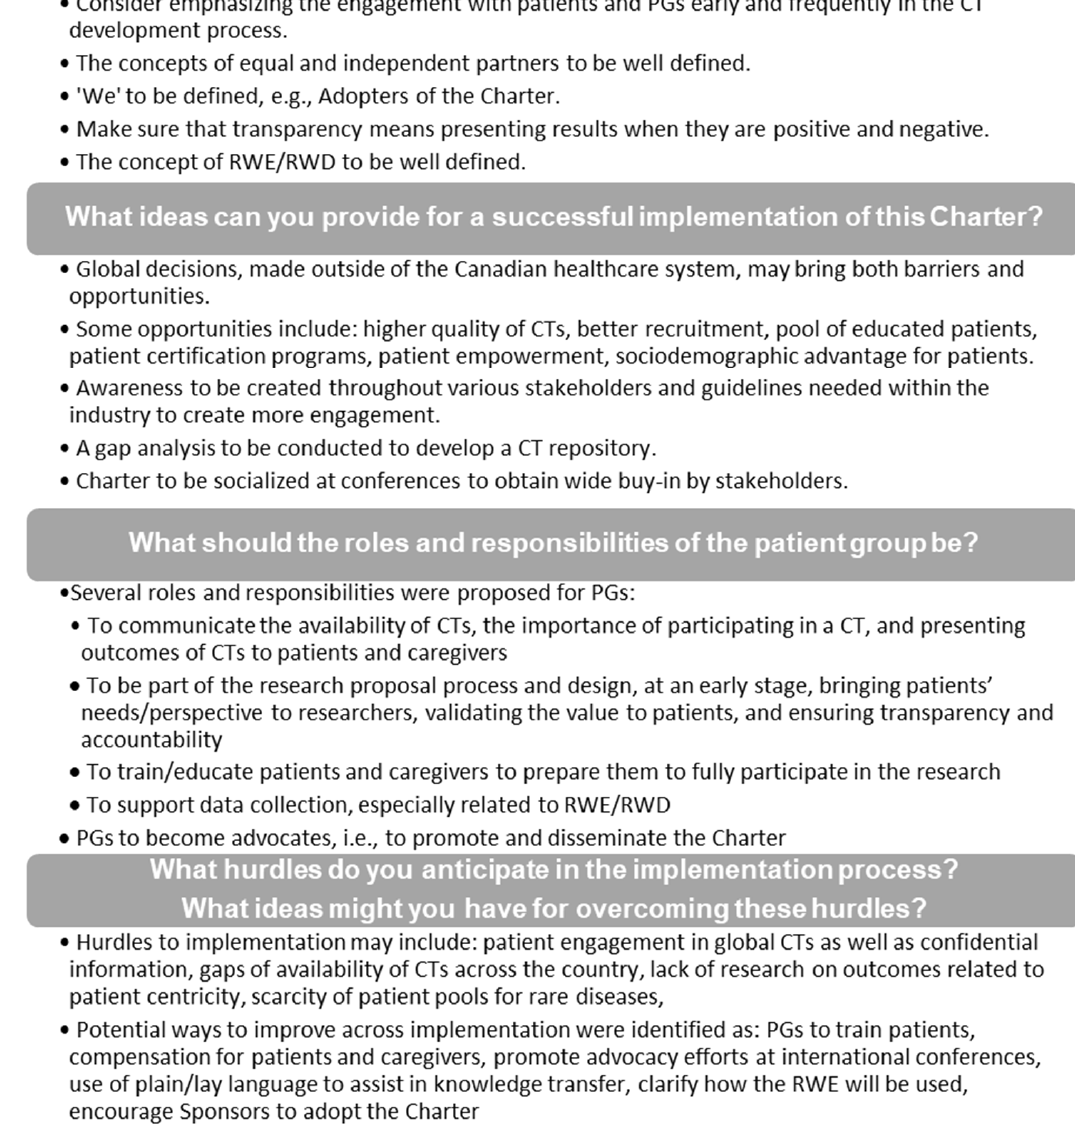
Figure 3. Summary of the feedback collected during the socialization of the draft Canadian Cancer Clinical Trials Stakeholder Charter, including the MVPs from the 2018 CCC conference. CCC: Colorectal Cancer Canada; CT, clinical trial; MVP: minimum viable product; PG, patient group; RWD, real-world data; RWE, real-world evidence.